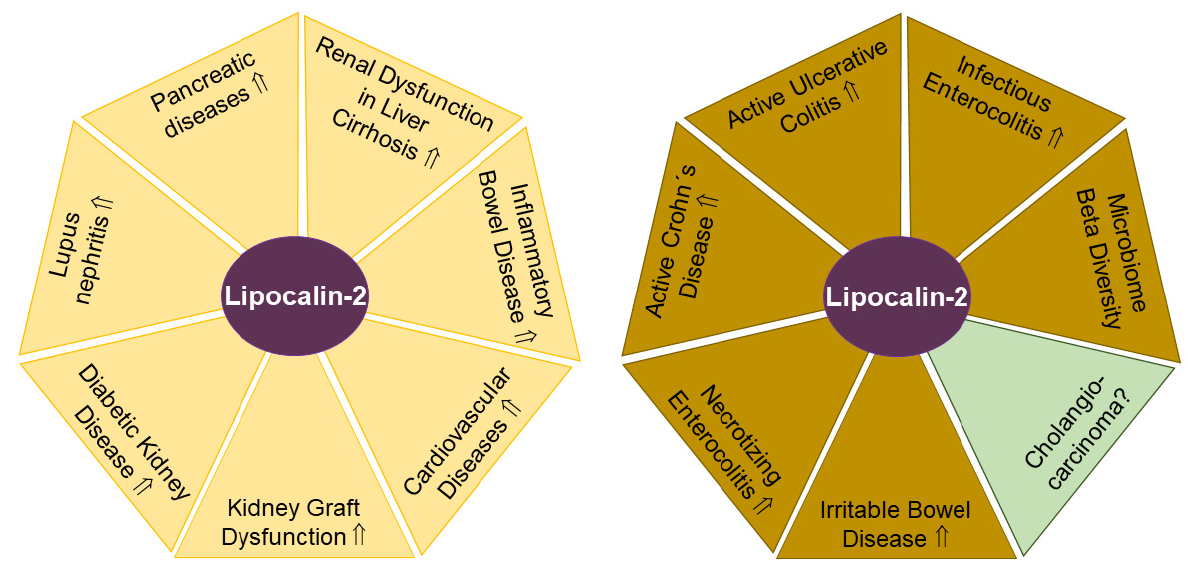
Figure 2. Lipocalin-2 levels in urine (yellow areas) and feces (light brown areas) have potential to serve as biomarkers for the indicated diseases. In cholangiocarcinoma (green) with altered biliary lipocalin-2 levels, the diagnostic and prognostic value of fecal lipocalin-2 remains to be clarified. Elevated ( ⇑ ) lipocalin-2 levels and a lack of data on lipocalin-2 amounts (?) in urine or feces in patients compared to the respective controls are